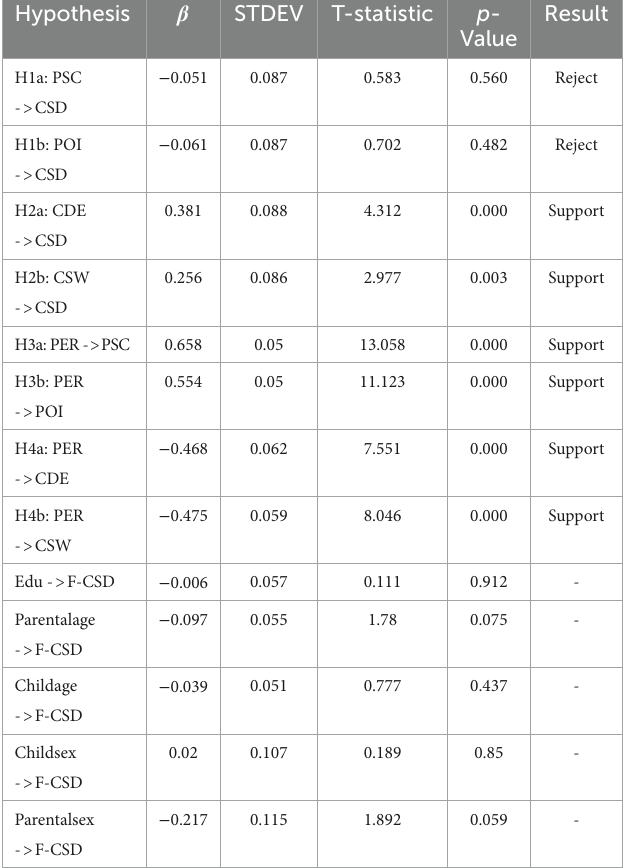
TABLE 3 Assessment of the structural model.